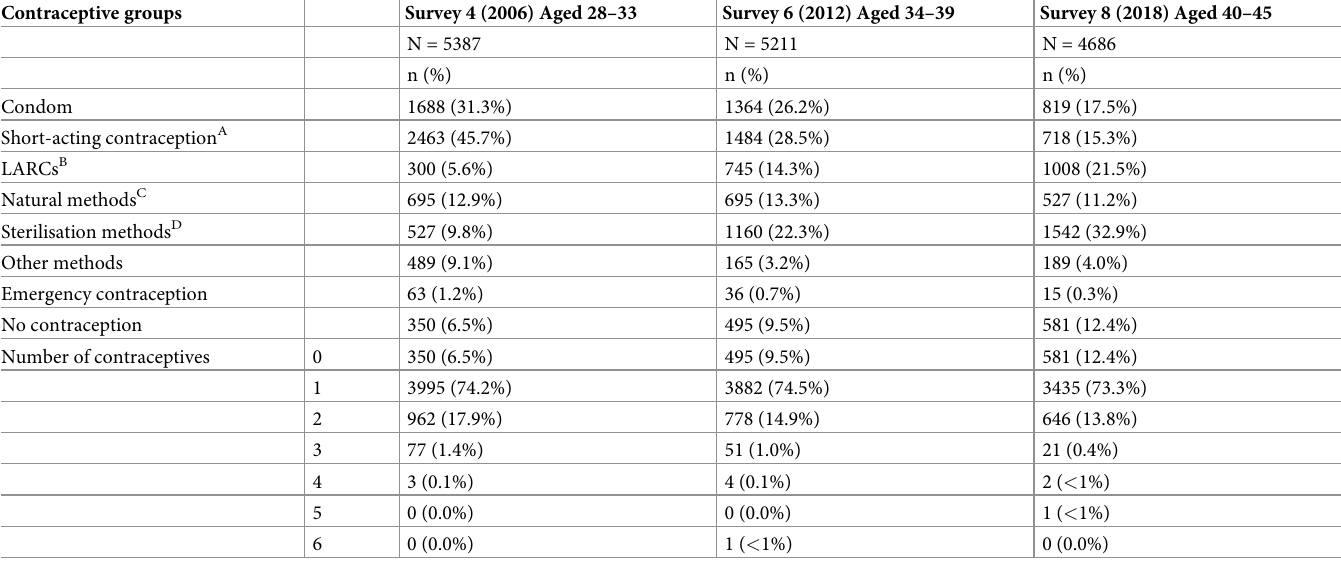
Table 1. Observed contraceptive use at each